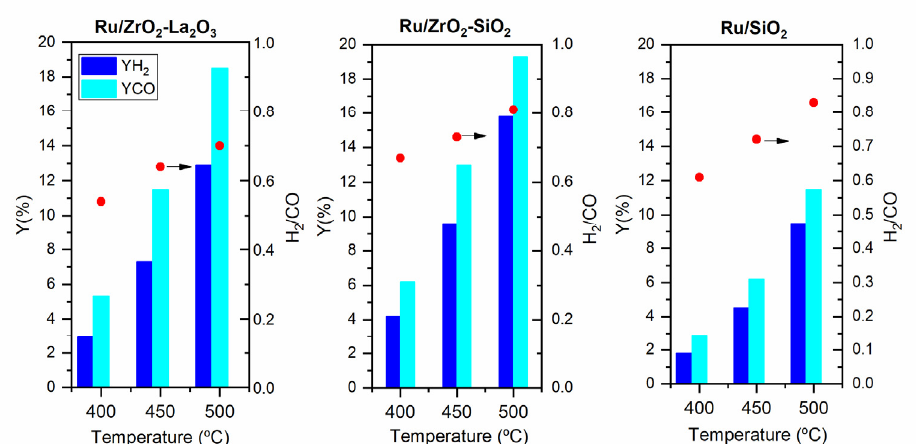
Figure 9. Yield of H 2 and CO, and H 2 /CO ratio as a function of the temperature for the DRM reaction carried out in the CR over Ru/ZrO 2 -La 2 O 3 , Ru/ZrO 2 -SiO 2 , and Ru/SiO 2 ; Feed composition: CH 4 : CO 2 : He = 10:10:80; Total flow rate = 100 mL/min: P = 1 bar.